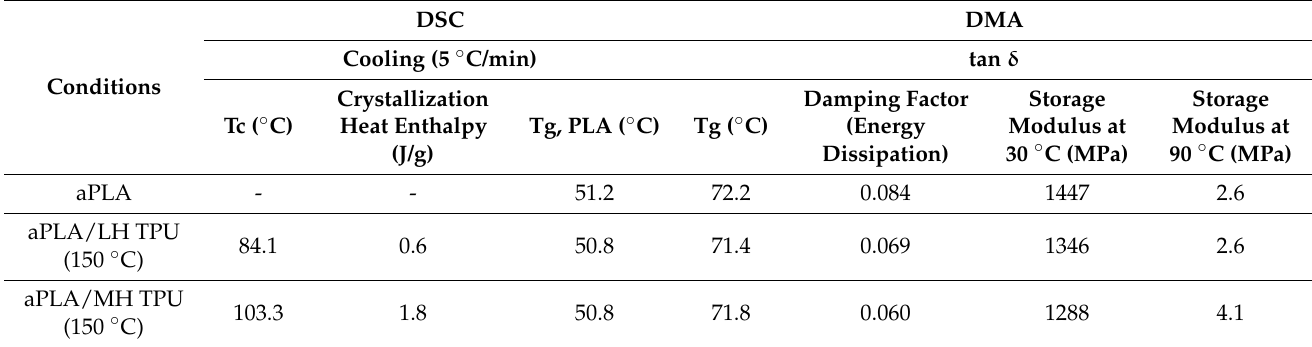
Table 9. DSC cooling and DMA temperature sweep graphs results [190].